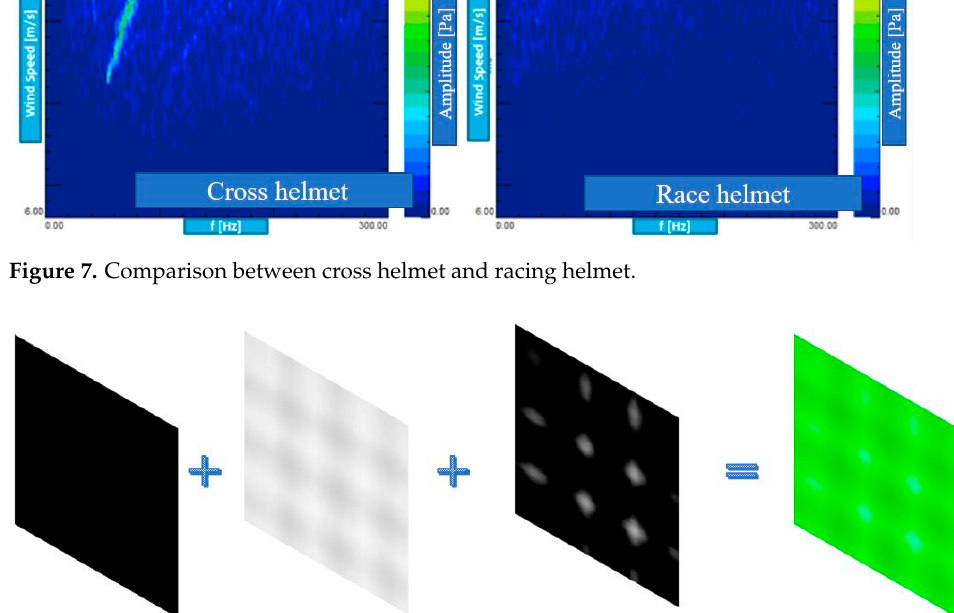
Figure 9. GASF matrices chosen to create RGB images. Red—moment; green—force; blue—sound level meter. These signals were chosen, since: •